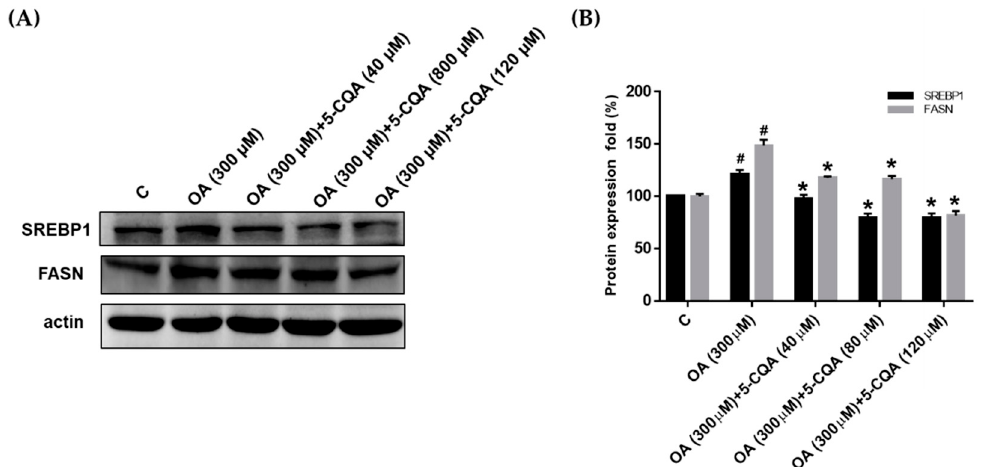
Figure 3. 5-CQA decreased the expression of enzymes involved in fatty acid synthesis. ( A ) The cells were treated with OA with or without 5-CQA (40, 80, or 120 µ M) for 24 h. Protein expression was detected by Western blot analysis against SREBP1 and FASN antibodies, with anti-actin as the internal control. ( B ) The data are presented as mean ± SD from three samples for each group. # p < 0.05, in relation to control group. * p < 0.05, in relation to OA-induced group.